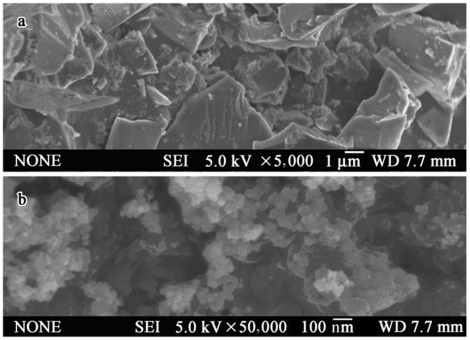
SEM images of nano-SiO2 (a) and nor-SiO2 (b).(JEOL-6700F).